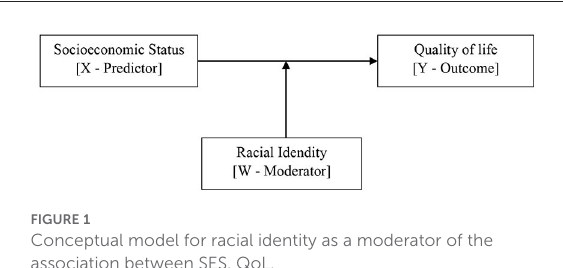
FIGURE1 Conceptual model for racial identity as a moderator of the association between SES, QoL.